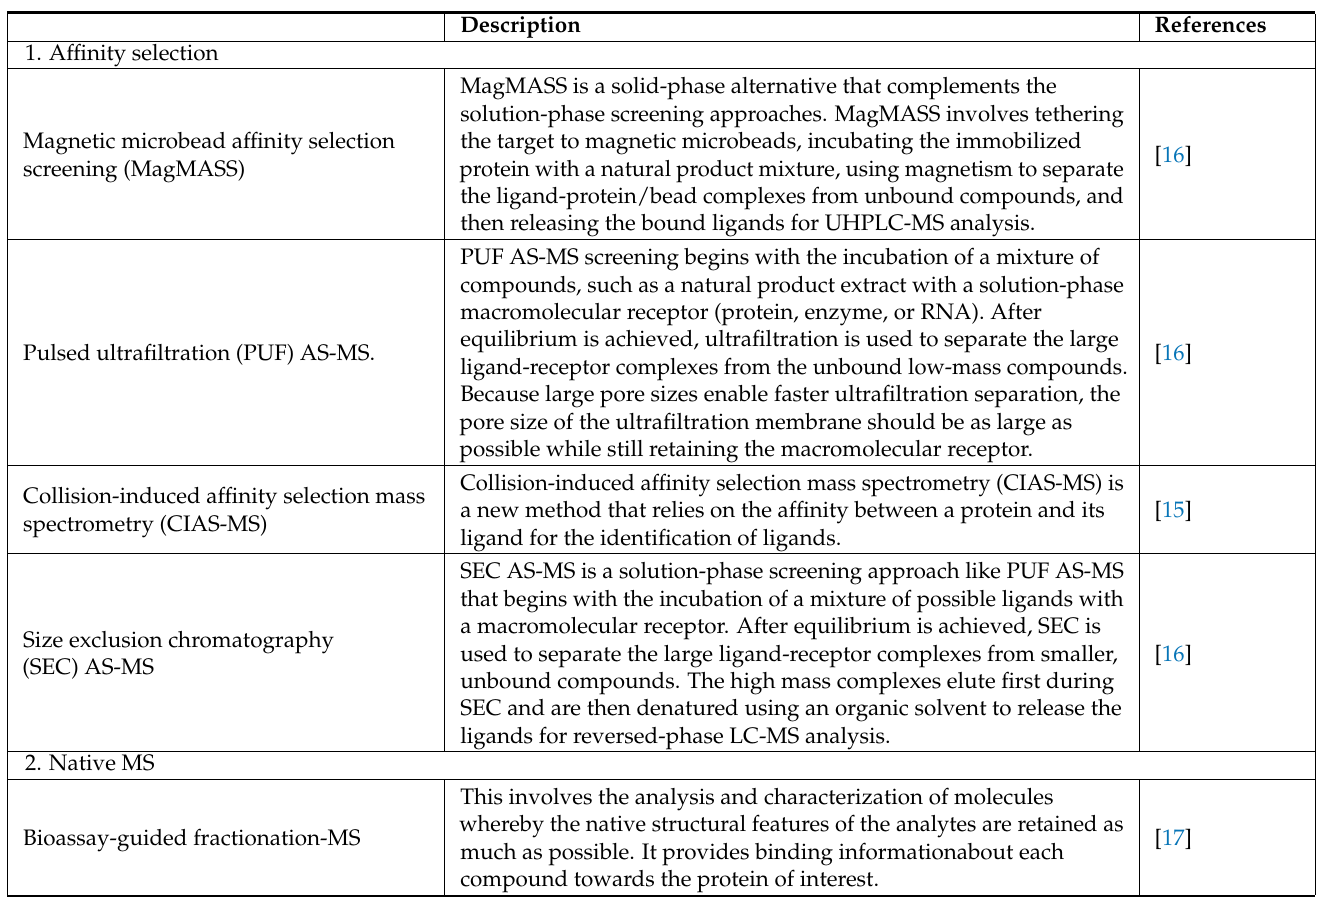
Table 1. Short description of native and affinity MS